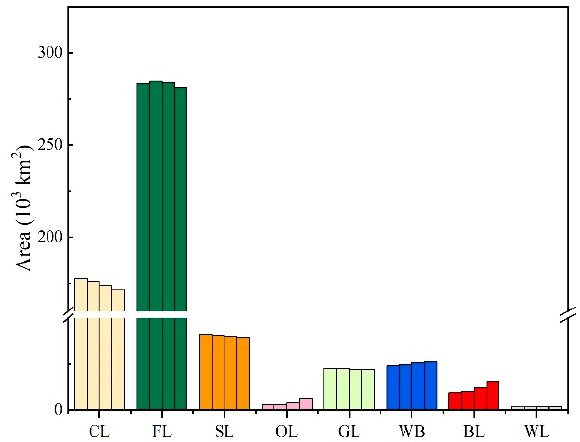
Figure 4. Changes in land use types in the MRYRR region from 1990 to 2015. The data in the color histogram represent the area of land use types in the study period (1990, 2000, 2010 and 2015) from left to right. Details of the abbreviations are shown in Table A2.